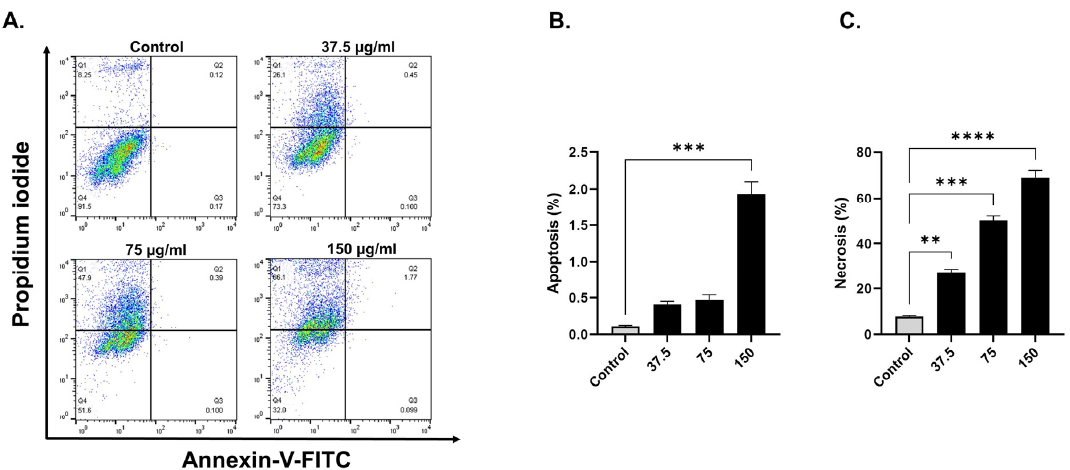
Figure 2. Evaluation of the apoptosis- and necrosis-inducing potential of ethanol extract of C. calcitrapa (EECC) in MCF-7. ( A ): FACS analysis of by Annexin V-FITC/PI double staining of MCF-7 cell after treatment with EECC at different concentrations for 48 h. EECC induced apoptotic and necrotic cell death in MCF-7cells. The Y-axis represents the PI-labeled population, whereas the X-axis represents the FITC-labeled annexin V positive cells. The four quadrants are representative of the following: Q1 quadrant (PI+/Annexin V − )—necrotic cells, Q2 quadrant (PI+/Annexin V+)—early apoptotic cells, Q3 quadrant